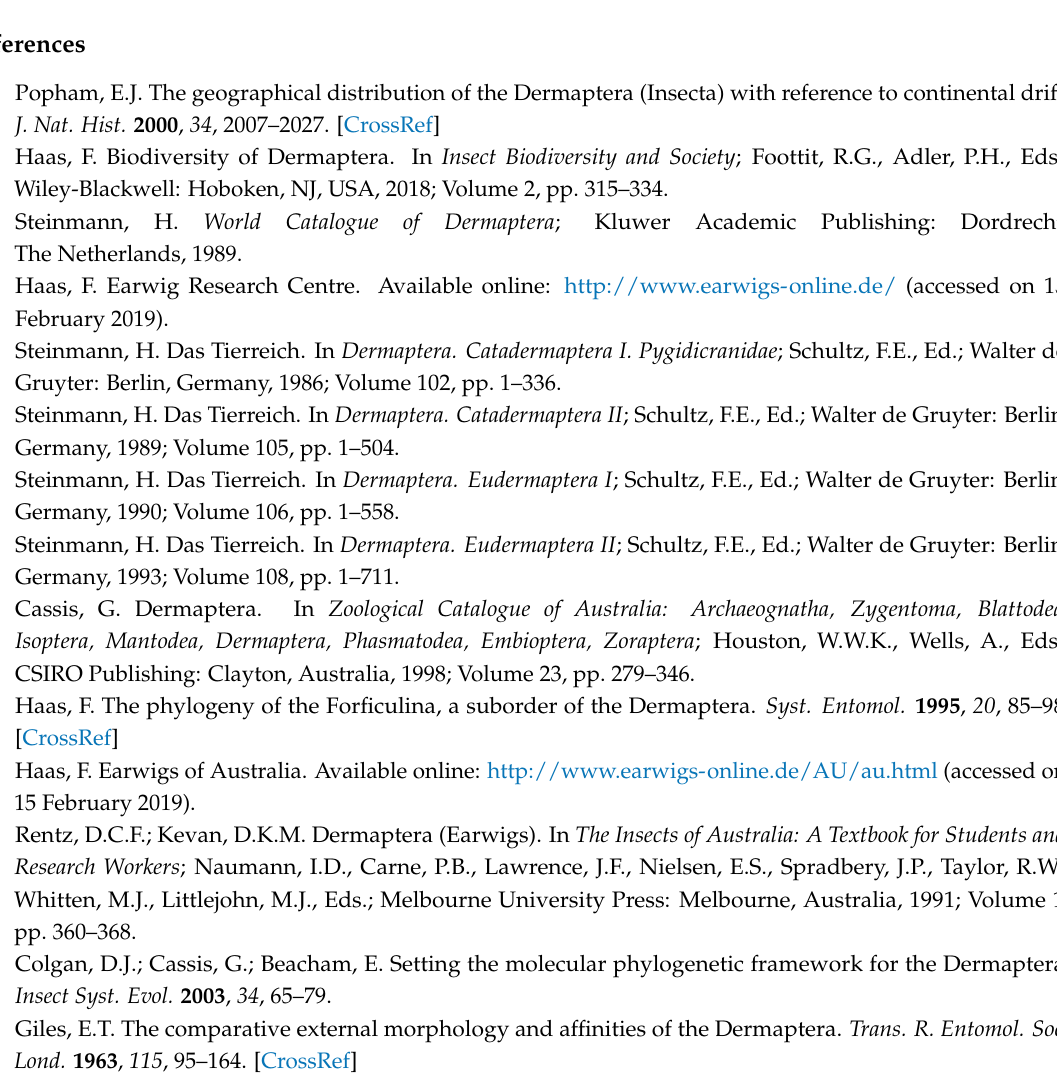
No dorsal bump near attachment of forceps, not to be confused with the lateral ridge where the forceps slide under the ultimate tergite at the attachment site . . . . . . . . . . . . .. Gonolabis forcipata 21 Forceps clearly curved upwards near tip; setae on final sternite very long; small projections on posterior edge of final dorsal tergite that align with forceps attachments creating straight edge between forceps attachment; thoracic sternites as dark as dorsal surface in places; femur uniformly brown or with a proximal light patch . . . . . . . . . . . . .. . . . . . . . . . . . . . . . . . . . . . . ... Gonolabis sp. 1 22 Forceps more or less straight towards tip; final sternite glabrous or covered in moderate length setae; pronounced projections on posterior edge of final dorsal tergite that align with forceps creating concave edge between forceps attachment; thoracic sternites lighter than dorsal surface; femur as dark as dorsal surface near trochanter and lighter towards tibia . . . . . . . Anisolabis sp.